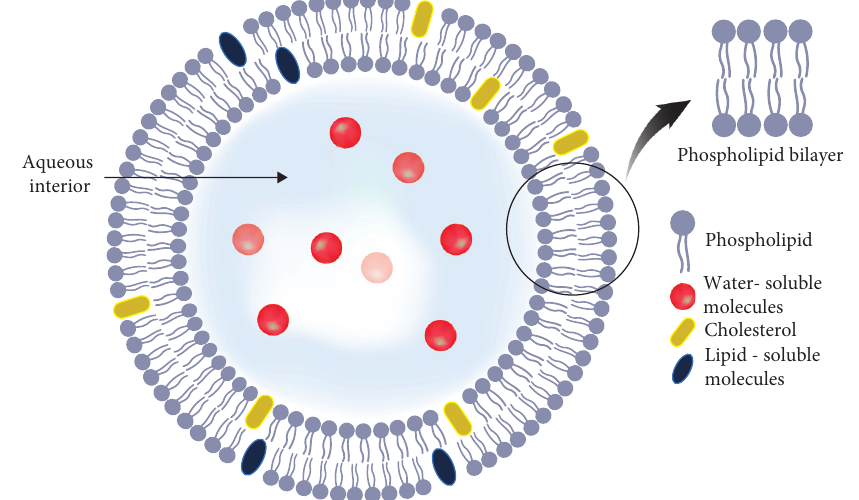
Figure 1: The cross-section of a unilamellar